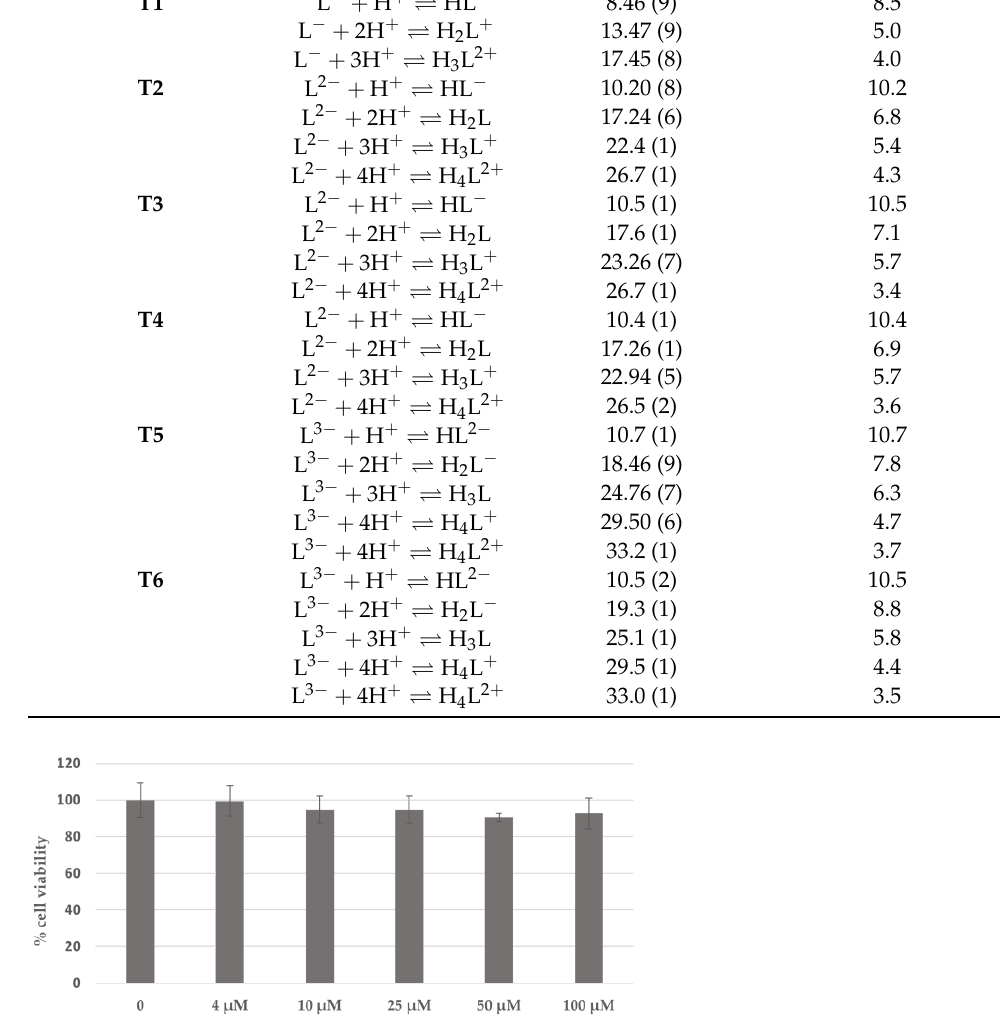
Figure 4. The effect of compound T6 on B16F10 cells at different concentrations (4–100 µ M). Data are expressed as a percentage of the control. Data are presented as the mean ± the SD from three experiments.